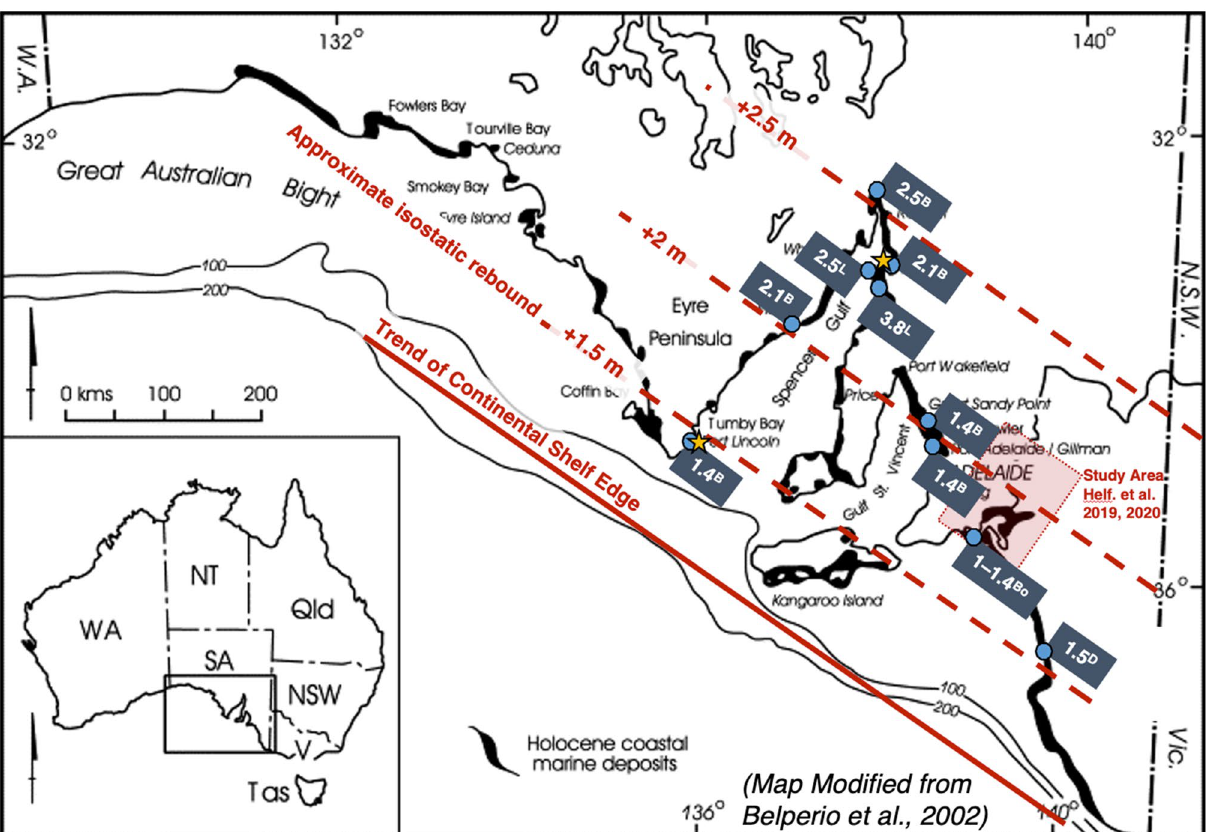
Figure 2. Map of coastal South Australia showing the distribution of indicators for Holocene highstand sea- level elevations presented by Belperio et al. 16 (B), Lambeck et al. 17 (L), Dillenburg et al. 22 (D) and Bourman et al. 23 (Bo). Here we present the maximum indicated relative sea-level elevation (in m) at each site (intertidal indicators; blue circles and associated labels) as well as approximated isostatic rebound contours (dashed red lines) oriented parallel to the approximate trend of the continental shelf edge (solid red line). These contours are representative values of post-mid-Holocene continental-edge load-stress relaxation induced 17 uplift, i.e., the systematic increase of hydro-isostatic uplift with distance from the shelf margin identified for the area by Belperio et al. 16 . We note that mid-Holocene highstand relative sea levels are poorly constrained between Port Lincoln and Port Pirie (gold stars; modelled as + 1 and + 2 m respectively in Belperio et al. 16 ), with sea level indicators proximal to the contour that passes through the mid-point of our study’s modelled spatial domain ranging from 1.4 to 2.1 m. As sea level estimates within this region are variable, we assert that our choice of + 2 m as an end-member value for modelling the mid-Holocene highstand mean sea-level is reasonable given the available